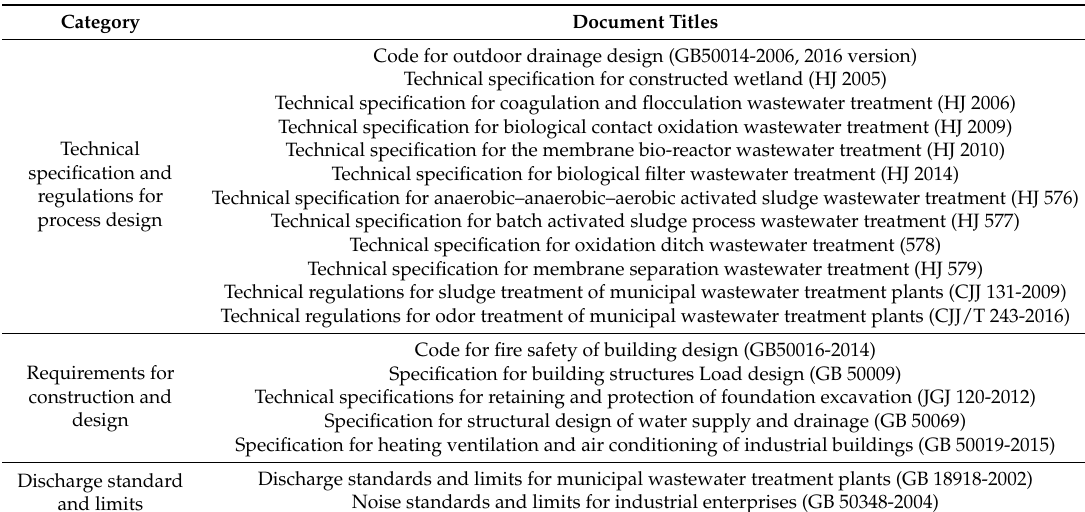
Table 2. Standardized documents including technical standards and specifications for conventional